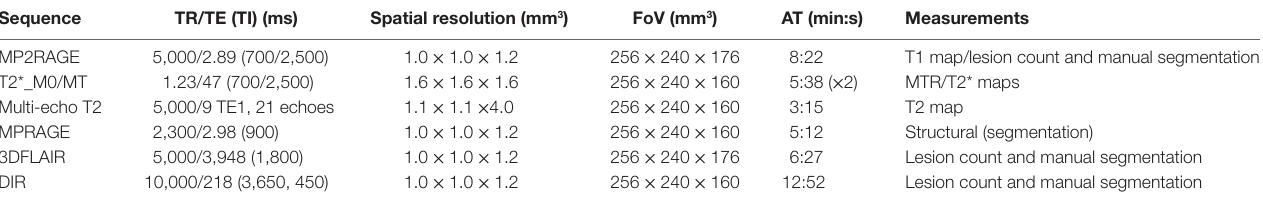
TaBle 3 | Magnetic resonance imaging